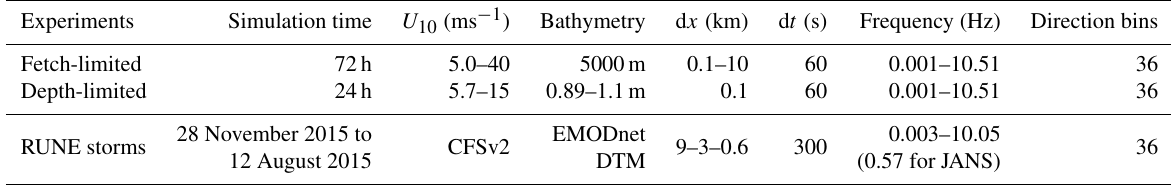
Table 3. A summary of model setups for all the experiments in Sect. 3. d x is the spatial resolution and d t is the time step of SWAN in seconds.